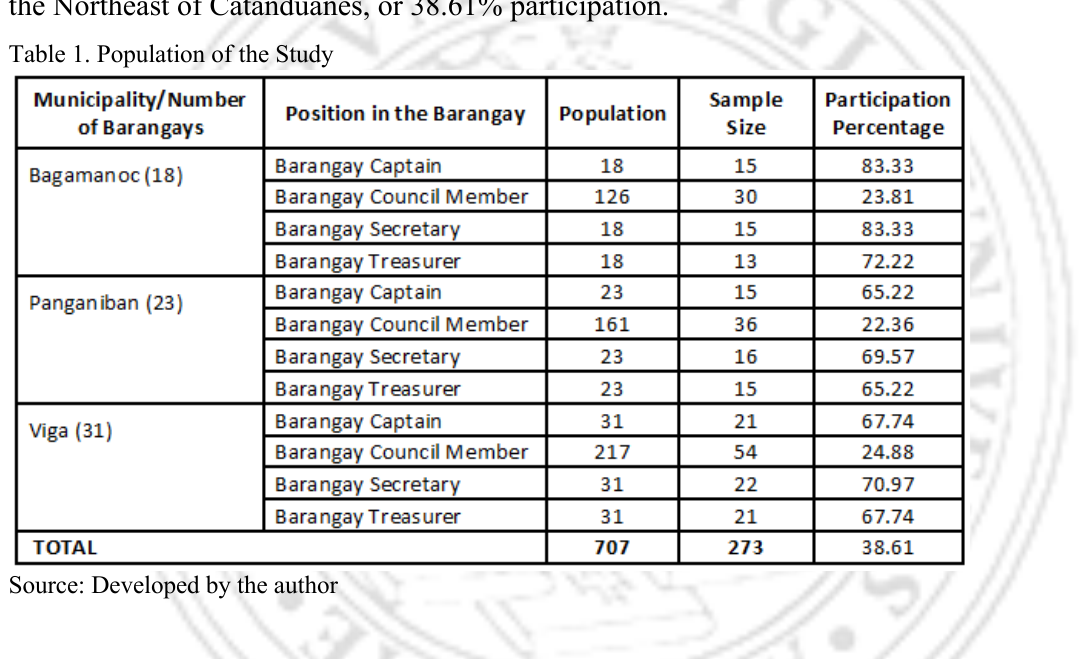
Table 1. Population of the